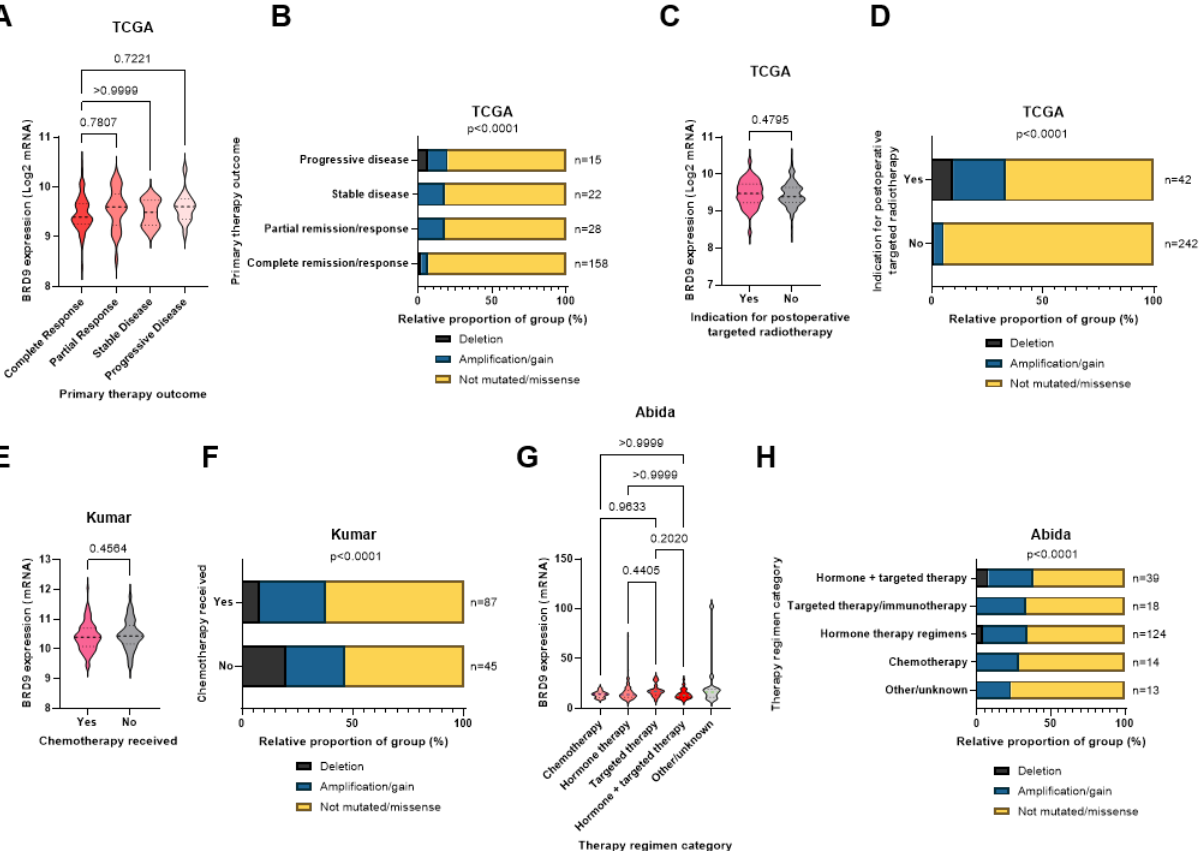
Figure 2. BRD9 as a predictive biomarker in PCa in cancer omics cohorts. ( A ) Violin plot showing how BRD9 expression varies with primary therapy outcome in the TCGA cohort. p -values were obtained using Dunn’s post-hoc test. ( B ) Stacked bar chart showing BRD9 mutation distribution across primary therapy outcomes and the number of patients in each sample in the TCGA cohort. p -value was obtained via Fisher’s exact test using the Monte Carlo simulation. ( C ) Violin plot showing BRD9 expression in patients indicated for adjuvant radiotherapy (left) and those who were not (right) in the TCGA cohort. p -value was obtained using a Mann Whitney U test. ( D ) Stacked bar chart showing BRD9 mutation distribution in patients who were and were not indicated for adjuvant radiotherapy and the number of patients in each sample in the TCGA cohort. p -value was obtained using Fisher’s exact test. ( E ) Violin plot showing BRD9 expression in patients who received chemotherapy (left) and those who did not (right) in the Kumar cohort. p -value was obtained using a Mann Whitney U test. ( F ) Stacked bar chart showing BRD9 mutation distribution in patients who did and did not receive chem- otherapy and the number of patients in each sample in the Kumar cohort. p -value was obtained via Fisher’s exact test using the Monte Carlo simulation. ( G ) Violin plot showing how BRD9 expression varies with therapy regimen in the Abida cohort. p -value s were obtained using Dunn’s post -hoc test. ( H ) Stacked bar chart showing BRD9 mutation distribu- tion in patients across therapy regimens the number of patients in each sample in the TCGA cohort. p -value was obtained using Fisher’s exact test. Regimen categories were combined as above due to small sample sizes (n) of various individual regimens. Y axis scales on violin plots vary due to experimental variation. 3.4. BRD9 May Play a Role as a Therapeutic Target in CRPC BRD9 and AR mRNA expression correlation and BRD9 expression in patients receiv- ing second generation antiandrogens (abiraterone and enzalutamide) was investigated. The TCGA cohort demonstrated a moderate negative correlation between BRD9 and AR expression in PCa patients (R = −0.4117, p < 0.0001) (Figure 3A). There was no significant difference in BRD9 expression and abiraterone and enzalutamide exposure status in the Abida and Dan cohorts ( p > 0.05) (Figure 3B,D); however, BRD9 mutations were more prevalent in patients treated with these drugs ( p < 0.0001) (Figure 3C,E)